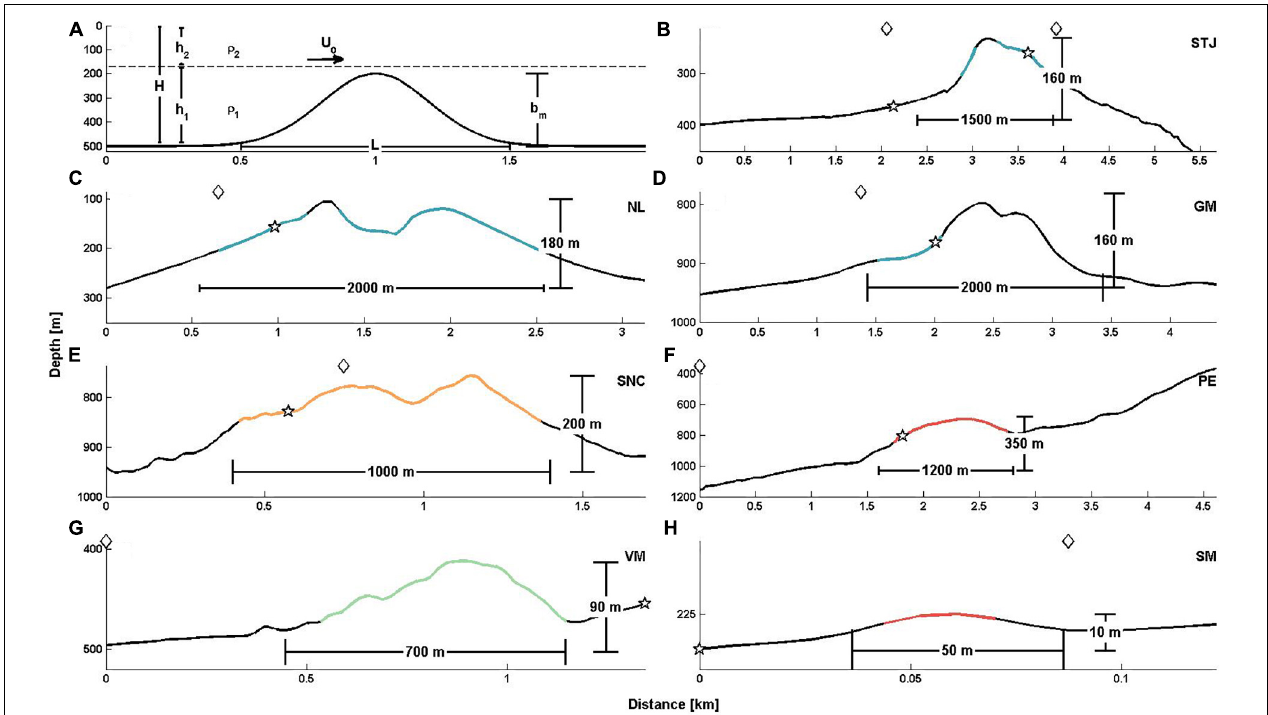
FIGURE 2 | (A) Definition sketch. H, total water depth; h 1 , lower layer water depth; h 2 , upper layer water depth; ρ 1 , mean density of the lower layer; ρ 2 , mean density of the upper layer; U 0 , horizontal flow speed; L, the width of the topography; b m , the height of the topography. (B–H) The morphology of sites with CWC growth marked by CWC category representative color (blue: I, green: II, orange: III, red: IV). The deployed lander positions are indicated by stars. In STJ two landers (STJ P on the left side and STJ S on the right side of the sill) were deployed. Diamonds in the upper part of each panel indicate the individual CTD locations. STJ, Stjernsund; NL, Nordleksa; GM, Galway Mound; SNC, St. Nazaire Canyon; PE, Pagés Escarpment; VM, Valentine Mound; SM, Sylvester Mound. Topography for GM from Beyer et al. (2006), and for VM and SM from Tamborrino et al.